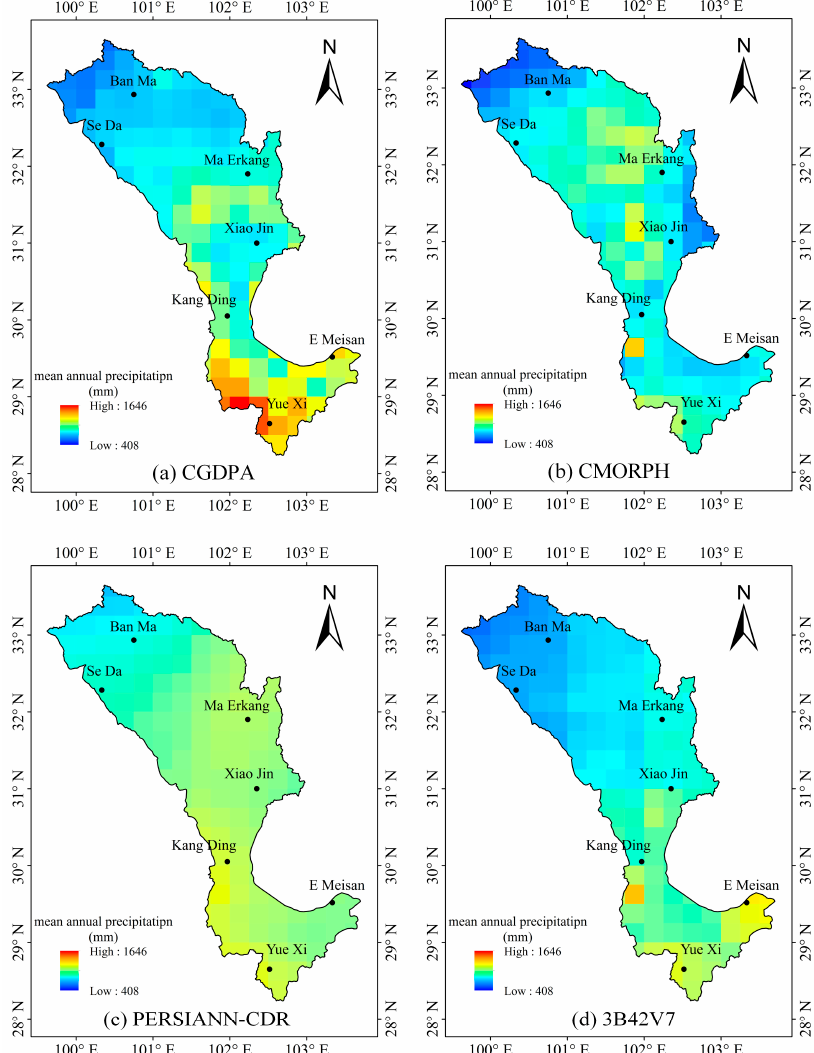
Figure 2. Spatial distribution of mean annual precipitation in the Dadu River basin from 1998 to 2013: ( a ) China Gauge-Based Daily Precipitation Analysis (CGDPA); ( b ) MORPHing algorithm (CMORPH); ( c ) Precipitation Estimation from Remotely Sensed Information using Artificial Neural Networks–Climate Data Record (PERSIANN-CDR); and ( d ) Tropic Rainfall Measuring Mission (TRMM) Multi-satellite Precipitation Analysis (TMPA) 3B42V7.